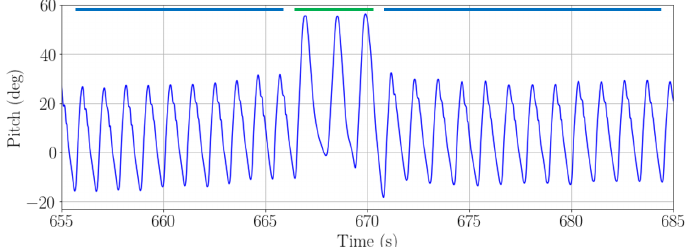
Figure 12. Pitch amplitude when a passenger is walking a 1.2 m high staircase with a smartphone in the front pocket of the trousers. The green solid line indicates the moment when the passenger is climbing a staircase. The blue solid line indicates the moment when the passenger is walking on a horizontal surface.